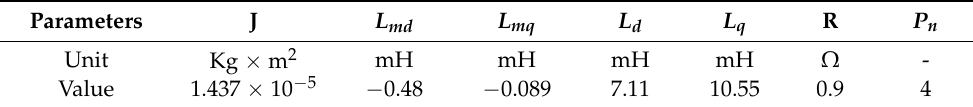
Table 2. Model parameters of two-stator